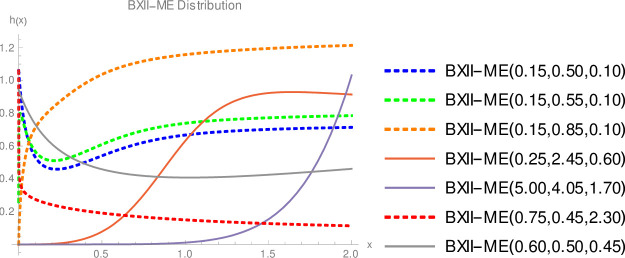
Plots of the BXII-ME hazard rate.